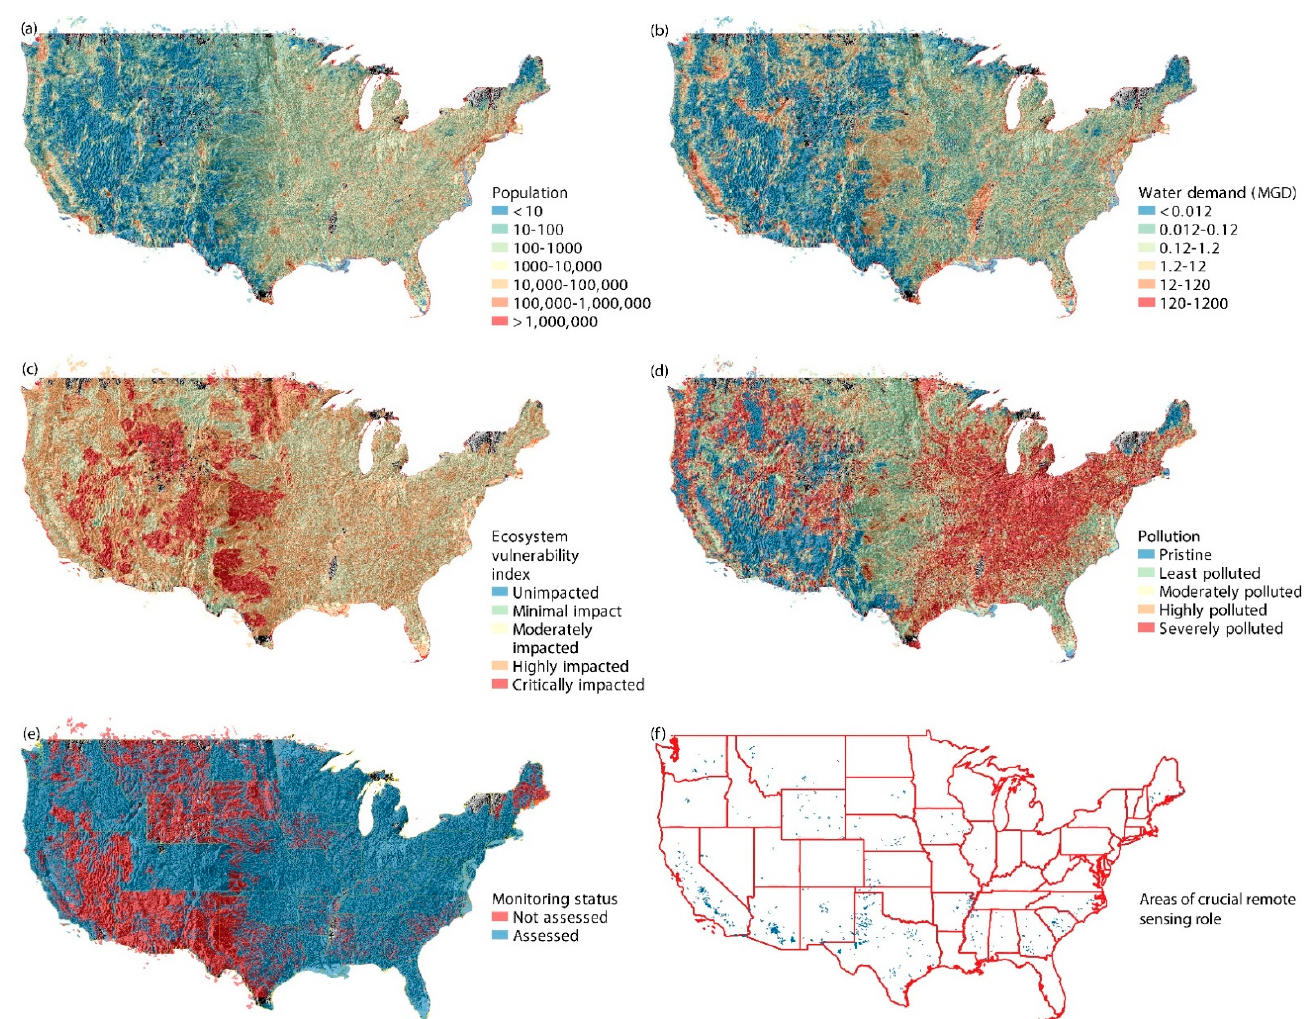
Figure 5. Predicted subwatersheds where the role of remote sensing could be crucial as the intersec- tion of greater than good remote sensing potential, high impairment risk indicators, and low coverage. Across subwatersheds, ( a ) population, ( b ) total water demand, ( c ) ecosystem vulnerability index, ( d ) pollution entering streams and waterbodies, ( e ) water quality monitoring gaps, and ( f ) intersection of these layers with normal accessibility and normal cloud cover cost-payoff model predicted higher than good remote sensing potential subwatersheds (blue polygons).